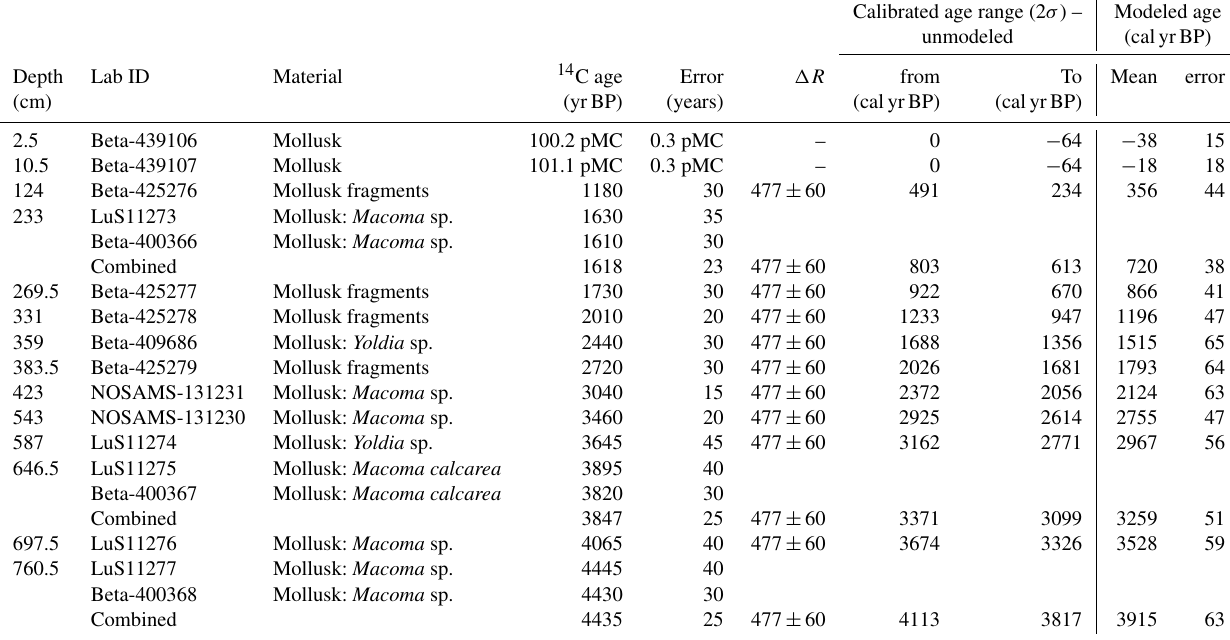
Table 1. Radiocarbon date list for core SWERUS-L2-2-PC1. All dates are calibrated using the Marine13 calibration curve (Reimer et al., 2013). The top two dates are reported in percent modern carbon (pMC) rather than years. BP: before present